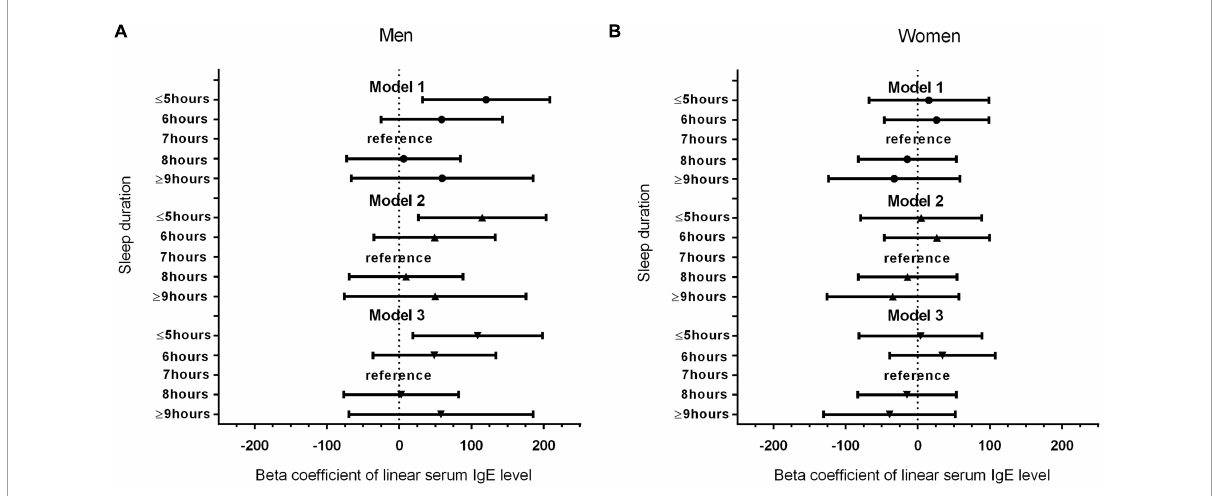
FIGURE1 (A) Association between sleep duration and serum IgE level in male participants. (B) Association between sleep duration and serum IgE level in female